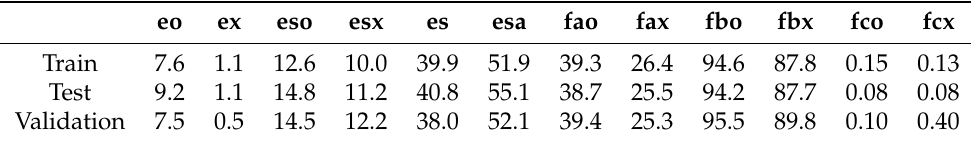
Table 3. The percentage of ionograms that contain the indicated signal class in the training, testing, and validation sets.